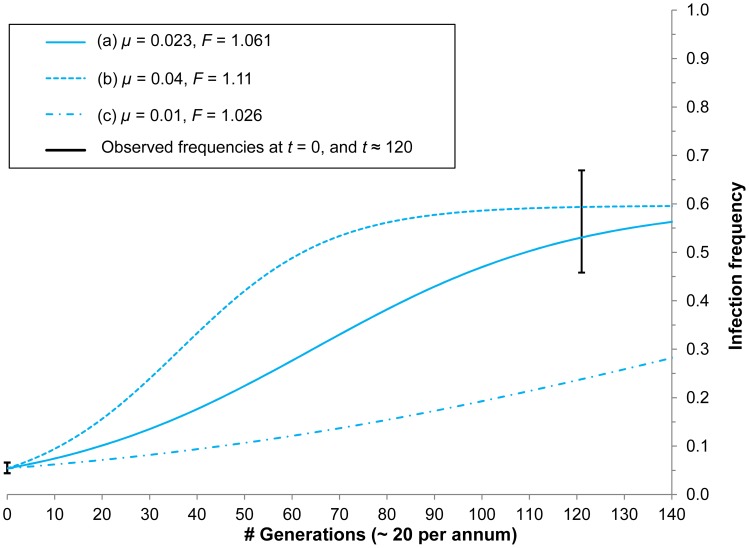
Predicted local wAu dynamics (where the infection increases host fitness (F
A) and offsets occasional loss of infection through maternal leakage) showing the observed increase in infection frequency between 1993/4 and 1999 assuming ∼20 host generations per annum at subtropical latitudes.If the stable equilibrium frequency  for wAu is ≈0.6, parameter combinations (a) and (b) are sufficient to explain the observed rate of increase, whereas combination (c) is not.